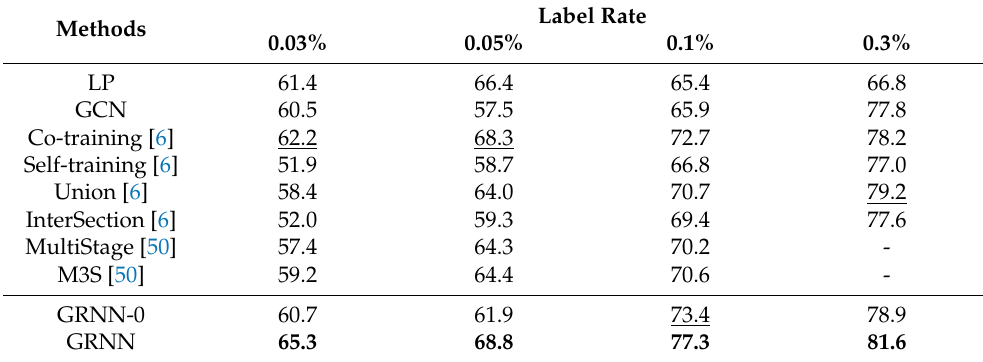
Table 6. Summary of classification accuracy (%) results with fewer training samples on